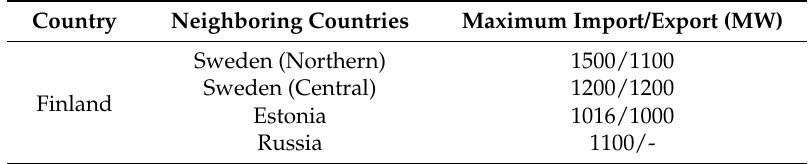
Table 4. Maximum import/export capacity between Finland and the neighboring countries.